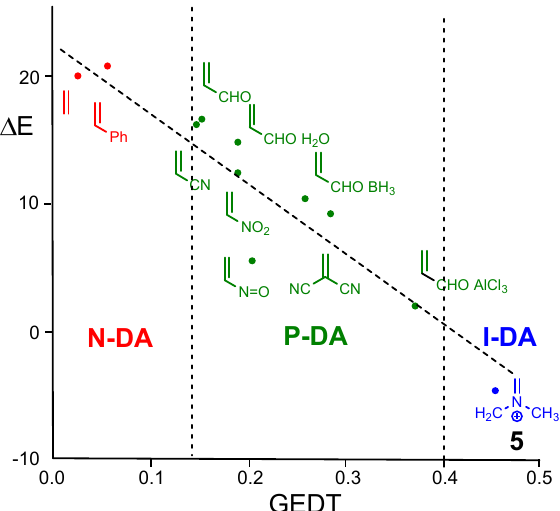
Figure 1. Plot of the activation barriers ( ∆ E in kcal · mol − 1 ) vs. the GEDT, e, R 2 = 0.89, for the DA reactions of Cp 4 with the substituted ethylene series of an increased electrophilic character. The classification of the DA reactions, based on the GEDT, is included.